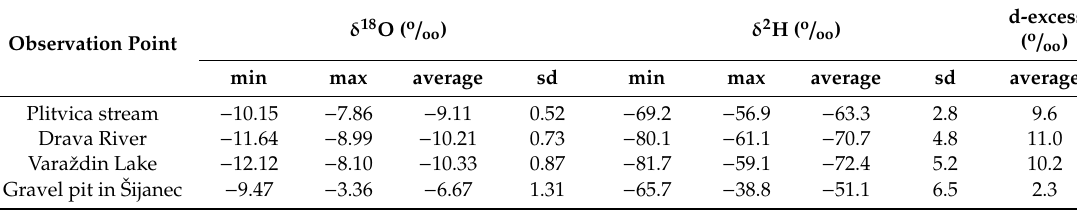
Table 8. Minimum, maximum, and averaged isotopic composition of surface